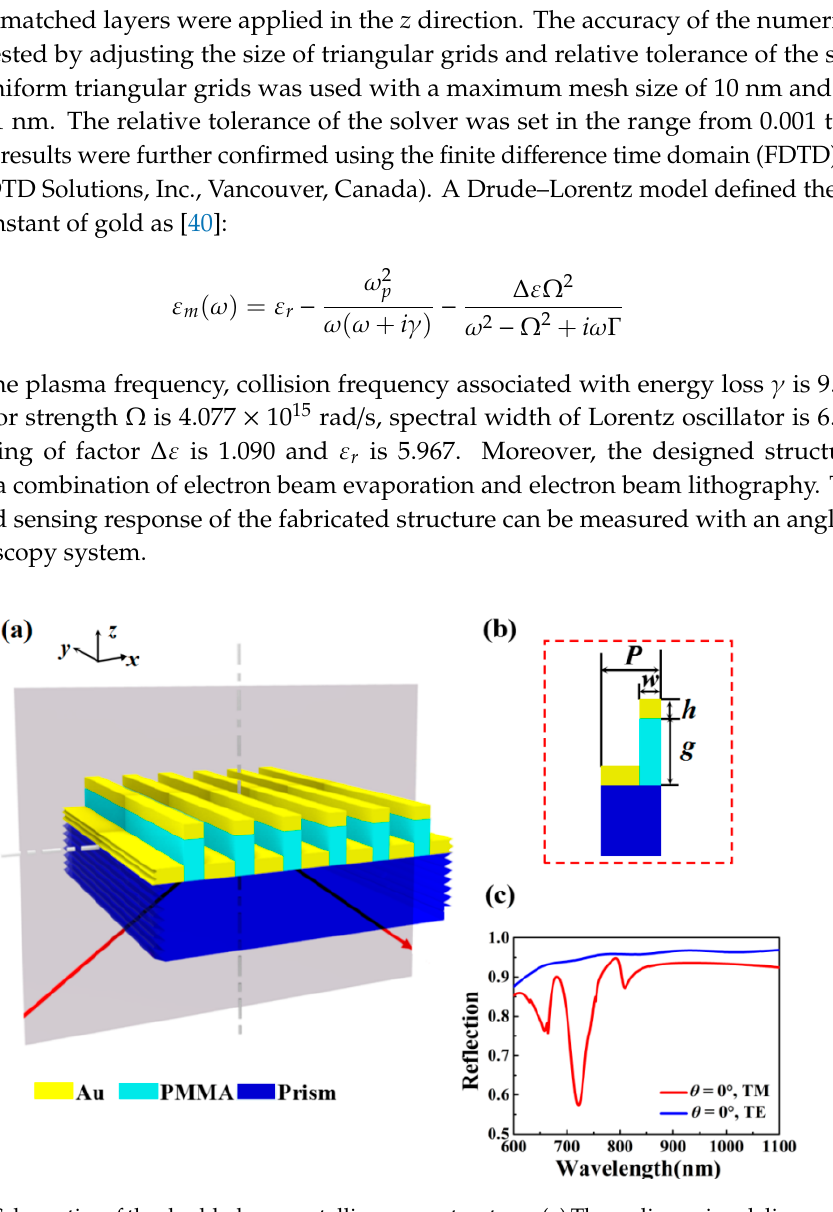
Figure 1. Schematics of the double-layer metallic groove structure. ( a ) Three-dimensional diagram of the designed structure consisting of two sets of metallic grooves upon the Kretschmann prism. ( b ) Grating diagram of one unit and corresponding structural parameters. ( c ) Typical optical spectra of the grooves for transverse magnetic (TM) and transverse electric (TE) polarized light under normal incidence.